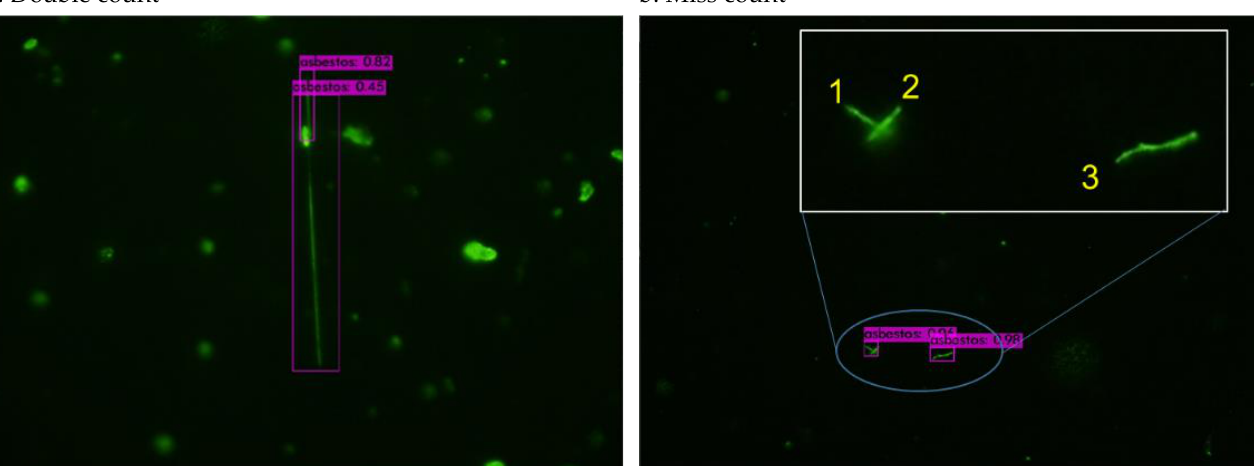
Figure 3. False positive (FP) and false negative (FN) examples.